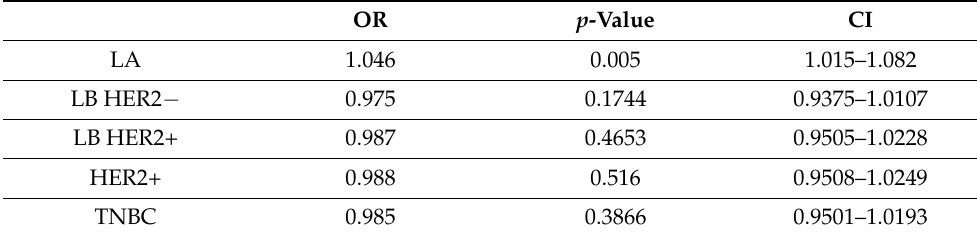
Table 5. Effect of age on occurrence of specific breast cancer Table 4. Characteristics of specific breast cancer subtypes using BIRADS lexicon.